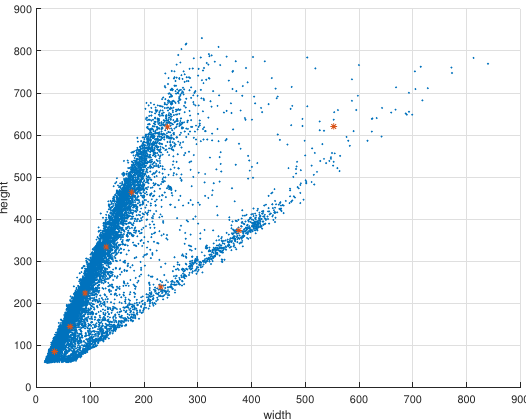
Figure 5. The K-means clustering result of training set. The x-axis and y-axis represent the width and height of bounding boxes in pixels. The blue point represents the instance and the red point represents the clustering point.